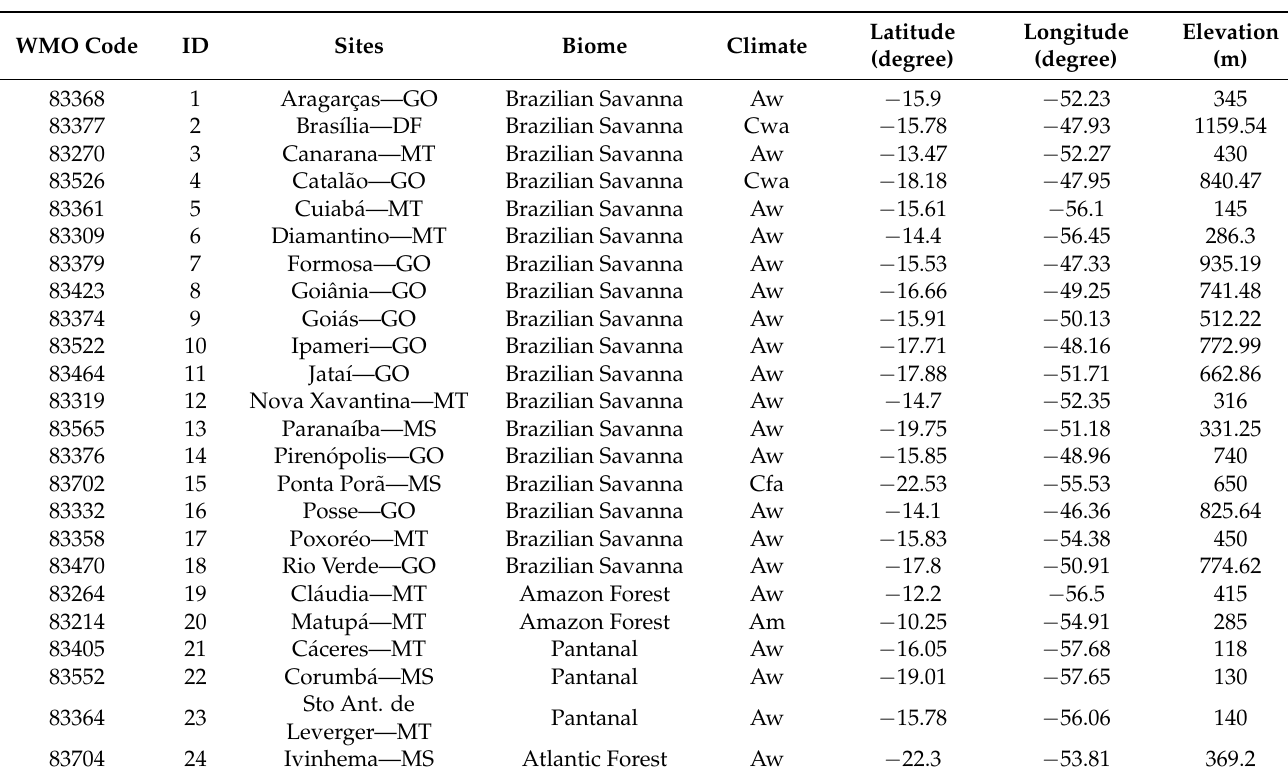
Table 1. Characterization of the conventional meteorological stations, WMO codes, ID, sites, biomes, climates, latitudes, longitudes, and elevations in the Brazilian